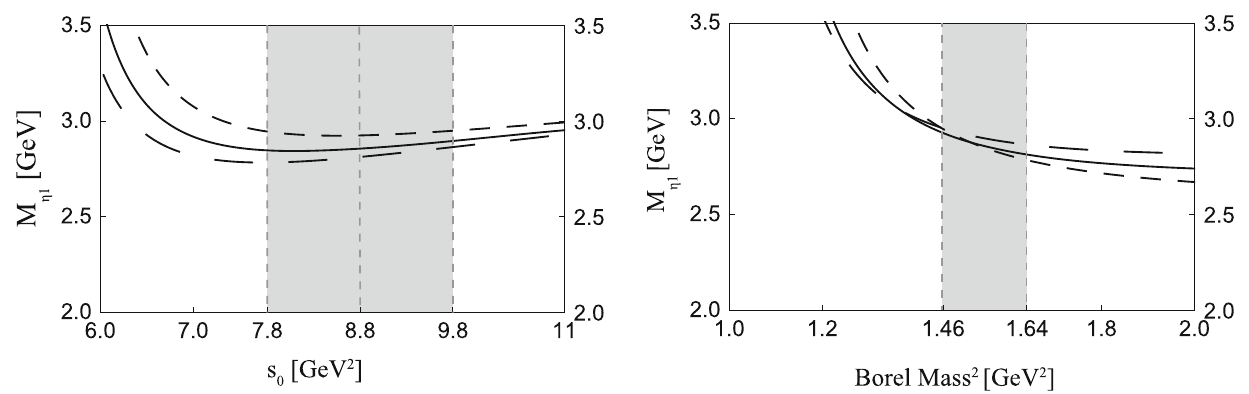
= 1 . 46 / 1 . 55 / 1 . 64 GeV 2 , respectively. In the right panel the ting M 2 B short-dashed/solid/long-dashed/dotted curves are obtained by setting s 0 = 7 . 8 / 8 . 8 / 9 . 8 GeV 2 , respectively